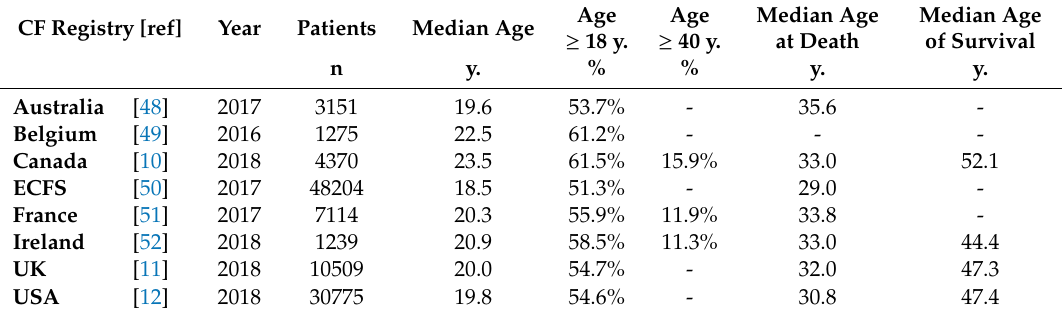
Table 1. Characteristics of the cystic fibrosis (CF) population and survival estimates presented in various CF registry annual data